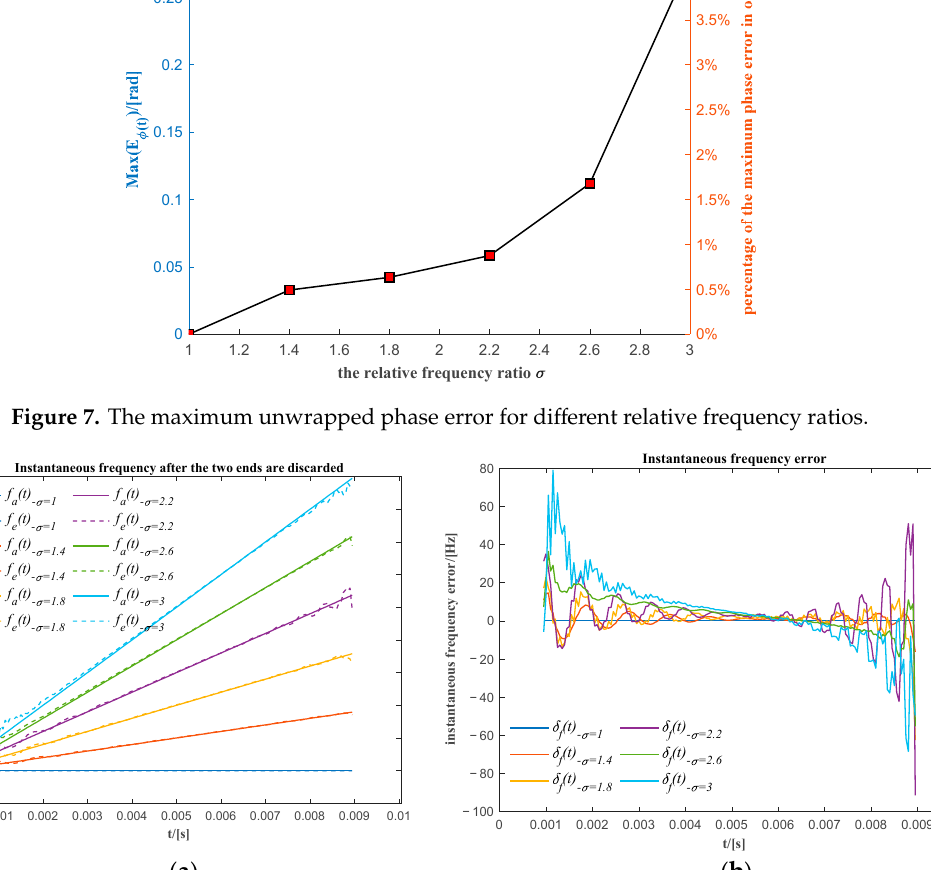
Figure 8. ( a ) The actual and the extracted unwrapped phase for different frequency variation ratios after the two ends are discarded; ( b ) the phase difference between the actual and the corresponding extracted unwrapped phase of the first sub-signal.